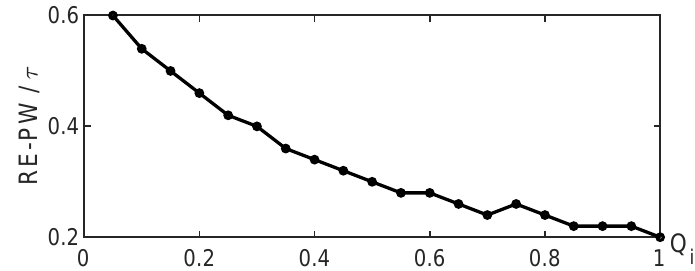
Figure 8. RE-PW versus Q in for a given τ and V TH = 0.8 × V p , V THE = 0.4 × V p